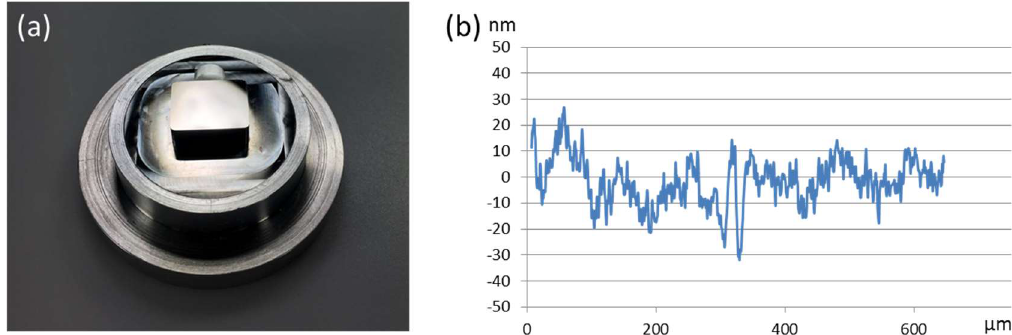
Figure 6. ( a ) Optical flat surface on a mold insert fabricated by fly cutting; ( b ) Resulting surface roughness of Ra = 8 nm measured by WLI.